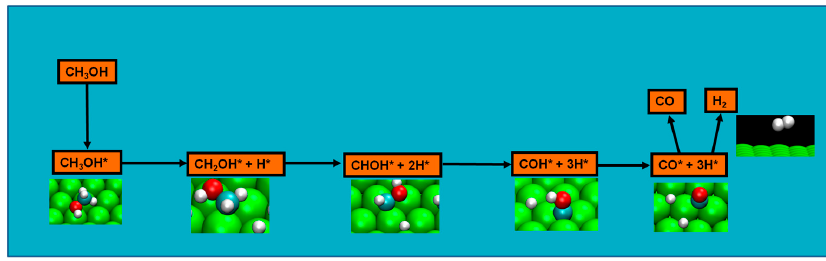
Figure 1. Representation of the methanol decomposition route starting by O–H bond scission. Red color stands for oxygen, blue for carbon, white for hydrogen and green for ruthenium.